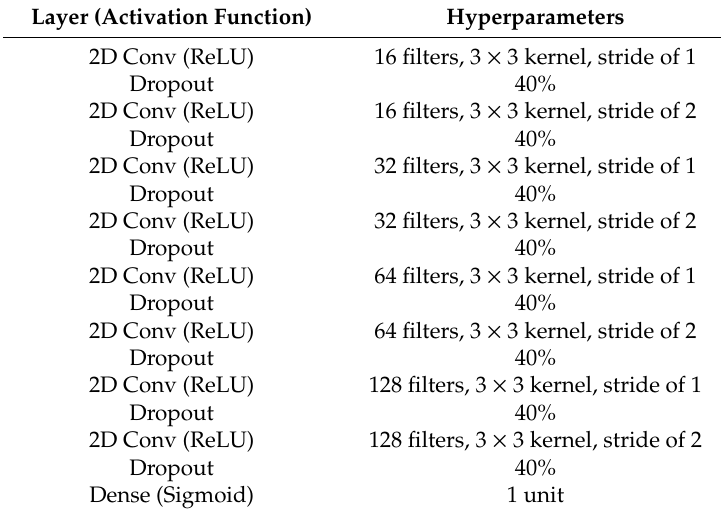
Table 1. Summary of the implemented convolutional network